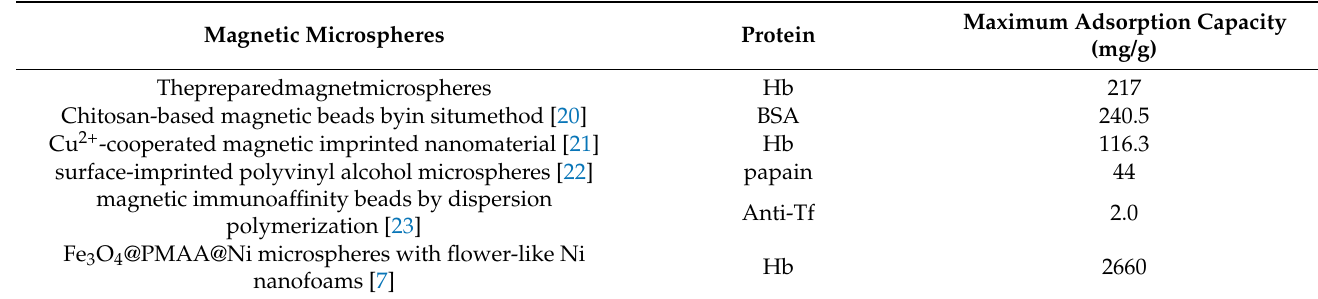
Table 1. Comparison of the adsorption capacity of several magnetic microspheres for proteins.